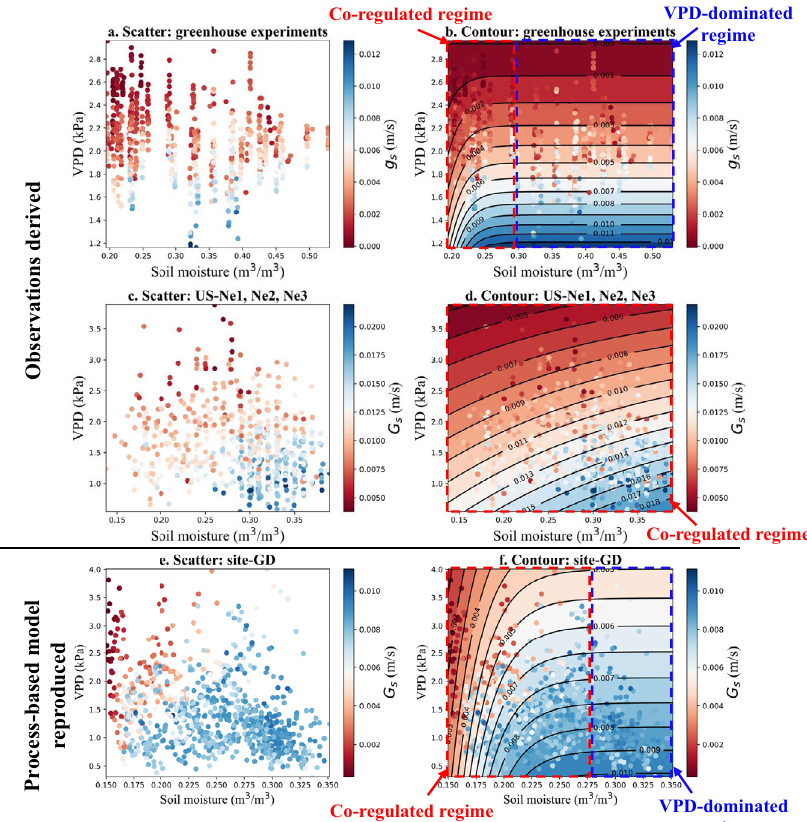
Fig. 2 The co-regulation pattern of soil moisture and VPD on stomatal conductance of maize at the daily scale. a , b Measurements of soil moisture, VPD, and leaf-level stomatal conductance ( g s ) of maize from greenhouse experiments. c , d Measurements of soil moisture, VPD, and derived canopy-level stomatal conductance ( G s ) using Penman-Monteith equation in the peak growing season (July and August) from 2001 to 2012 at three eddy covariance sites (US-Ne1, US-Ne2, and US-Ne3) under maize cropping systems. e , f Simulations of soil moisture, VPD, and G s from the ecosys model in the peak growing season (July and August) from 2001 to 2019 at site-GD in Nebraska under continuous maize cropping systems. The contours shown in c, d and f are fi tted using a statistical model (see Methods) with R 2 of 0.64, 0.54, and 0.62,